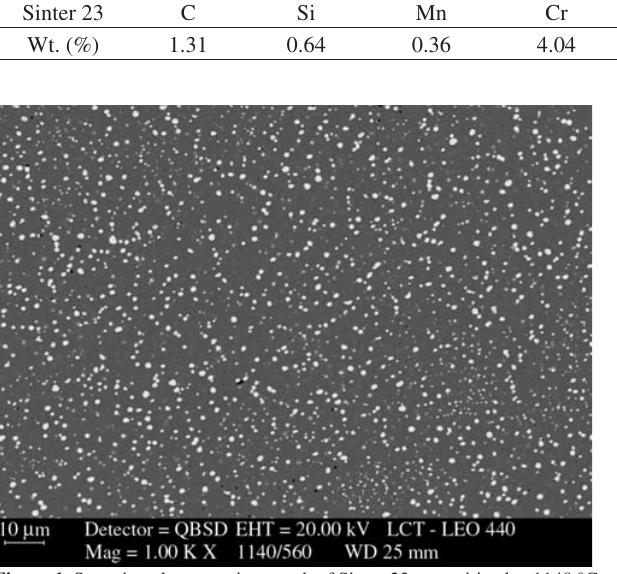
Figure 3. Scanning electron micrograph of Sinter 23 austenitized at 1180 °C and tempered at 560 °C.